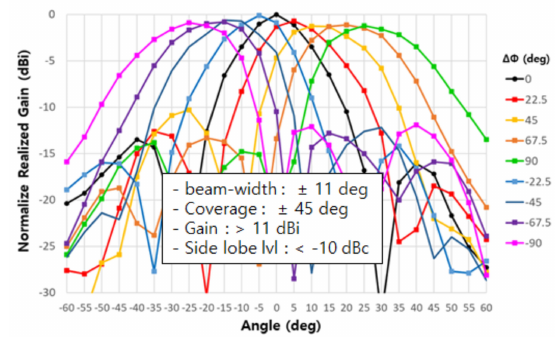
Figure 14. Measurement results of the beam patterns.